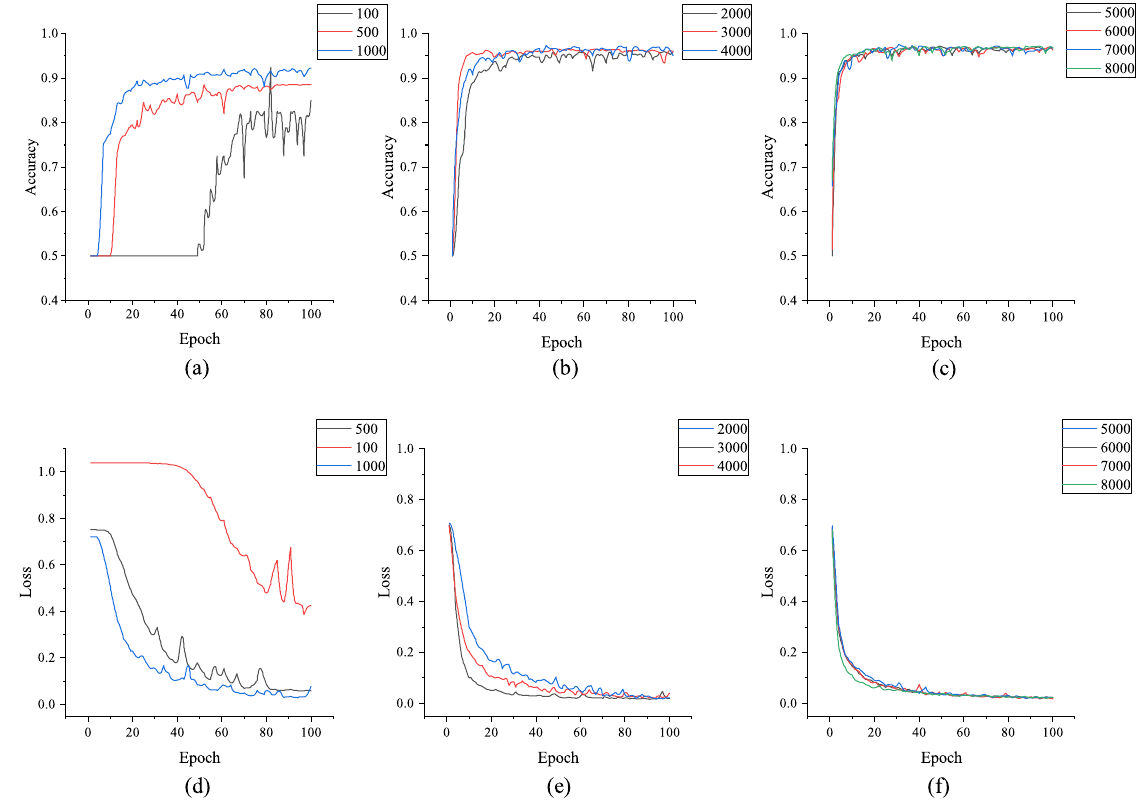
Figure 16. Accuracy curves and loss curves achieved by the model on the validation set after training with different numbers of data sets: ( a – c ) the accuracy curves; ( d – f ) the loss